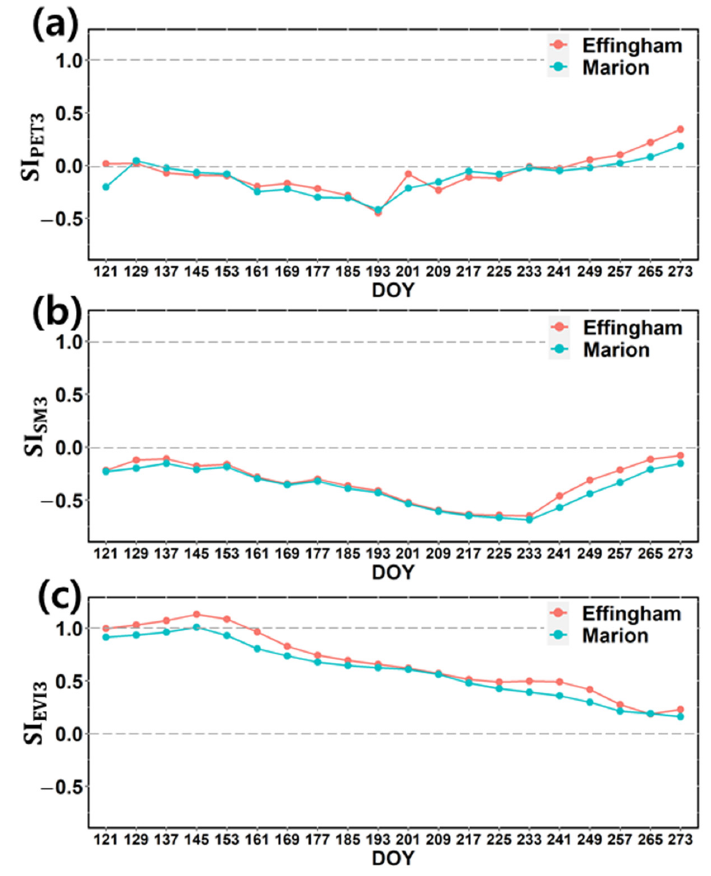
Figure 9. Time-series of ( a ) 𝑆𝐼 (cid:3017)(cid:3006)(cid:3021)(cid:2871) , ( b ) 𝑆𝐼 (cid:3020)(cid:3014)(cid:2871) , and ( c ) 𝑆𝐼 (cid:3006)(cid:3023)(cid:3010)(cid:2871) in Effingham and Marion in 2006.